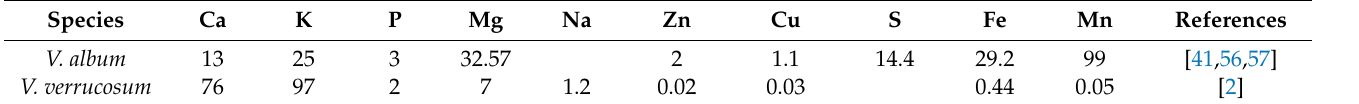
Table 3. Mineral content (g/kg DM) of Viscum ssp.